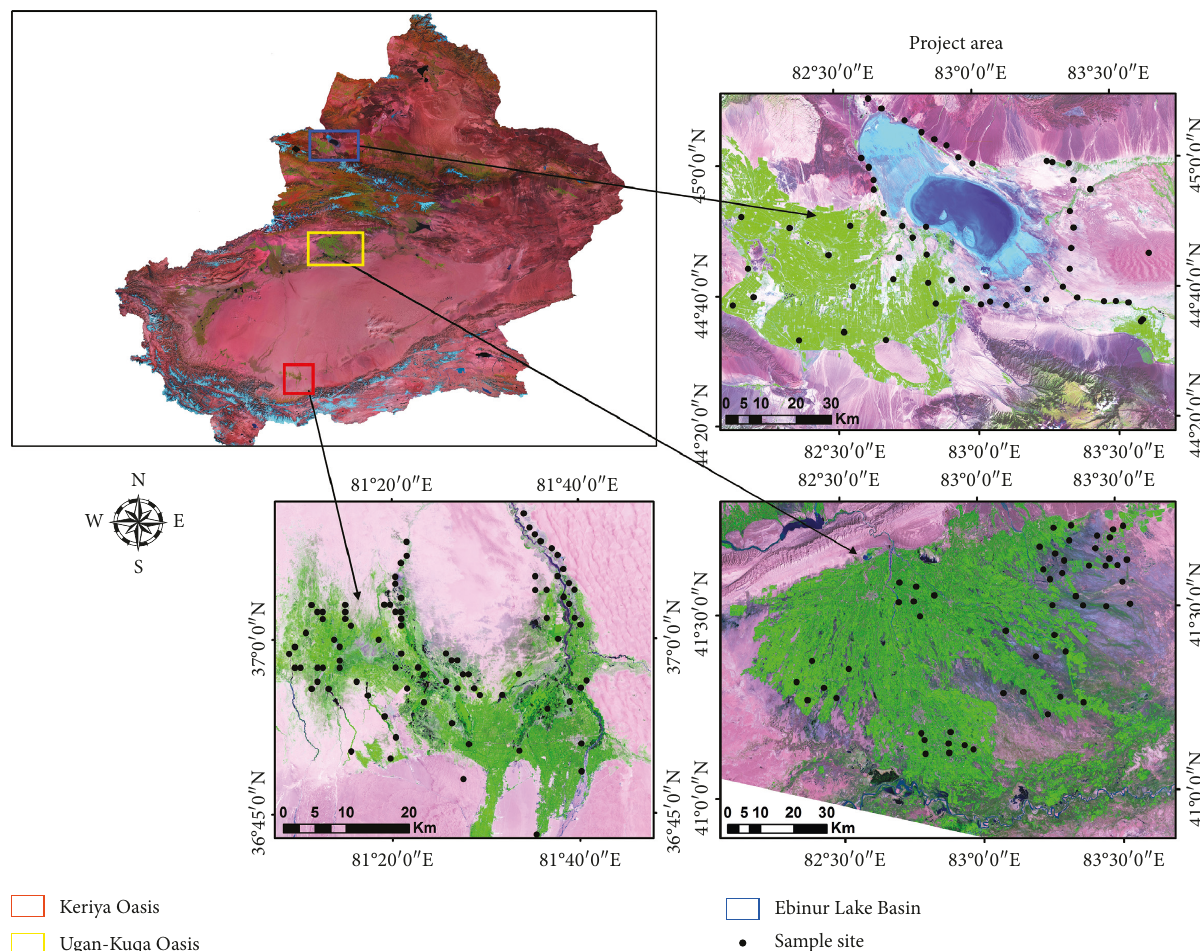
Figure 1: Study area with the sample